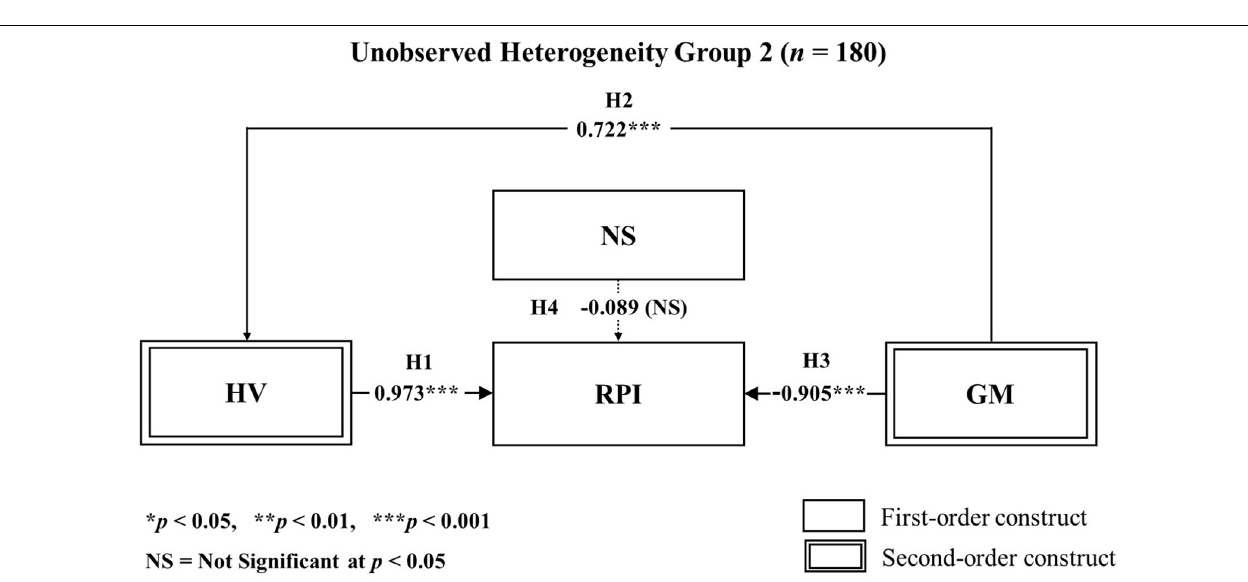
FIGURE 6 | Results of PLS-SEM hypothesis testing on segmented groups according to unobserved heterogeneity group 1 ( n = 260) Analysis.